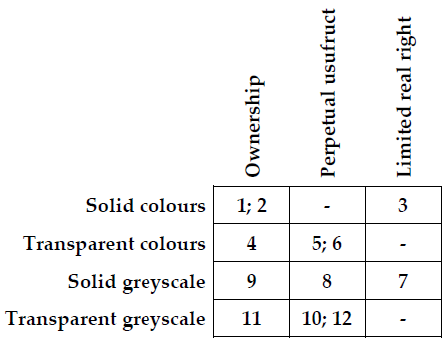
Figure 8. Diagram according to which the effect of the visualization parameters on the correctness of the determination of the right assigned to the property was analyzed (question numbers are given in the cells).